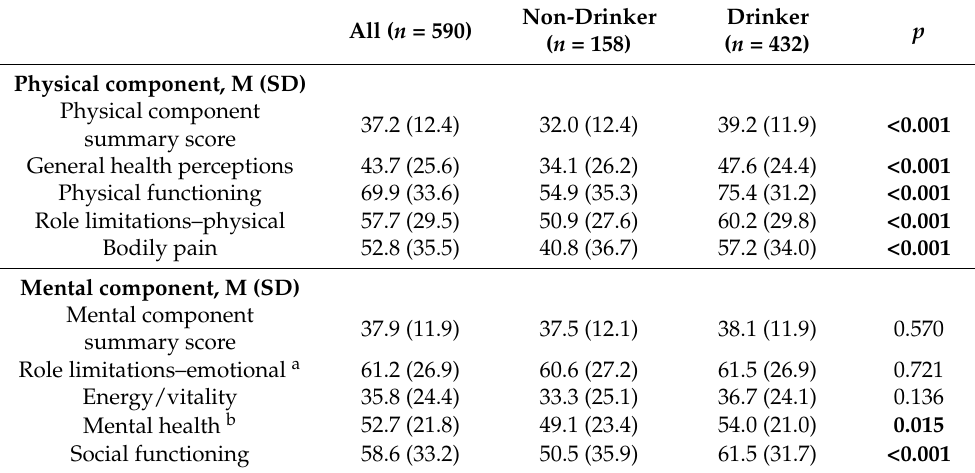
Table 2. Mean health-related quality of life